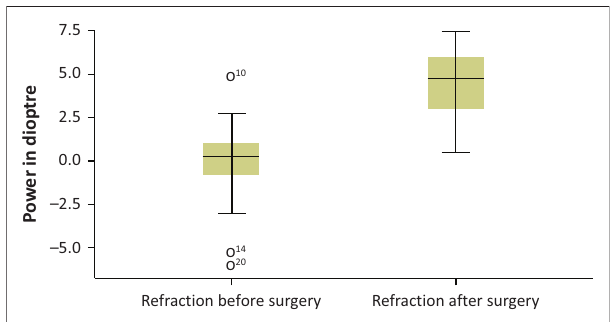
FIGURE 2: Refraction before and after